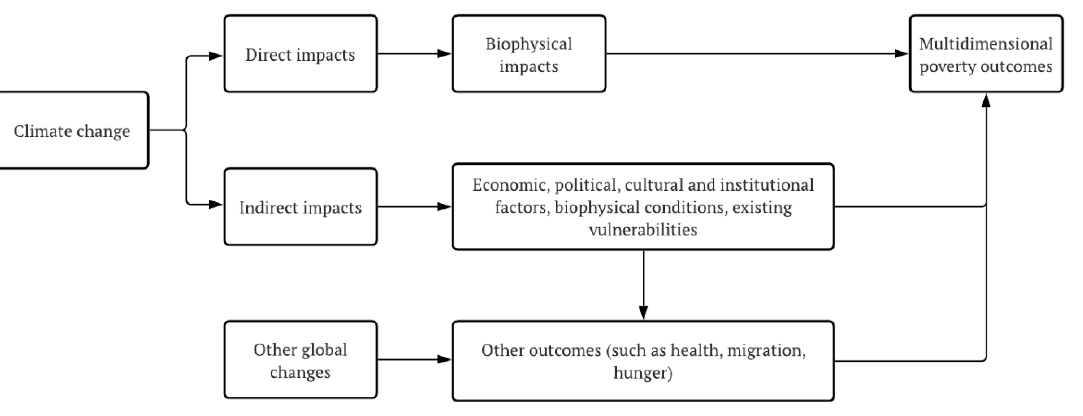
Figure 3. Climate change impacts on societies (adapted from [32]).